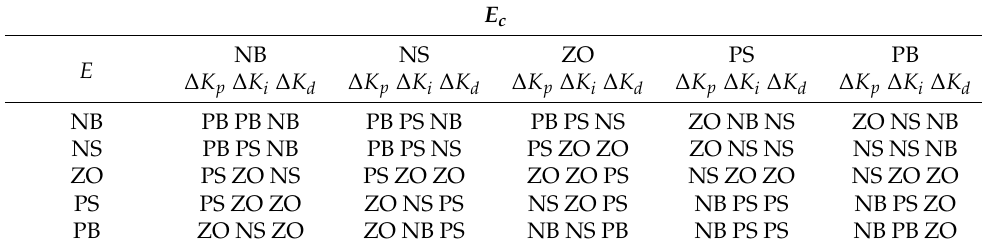
Table 1. The fuzzy control